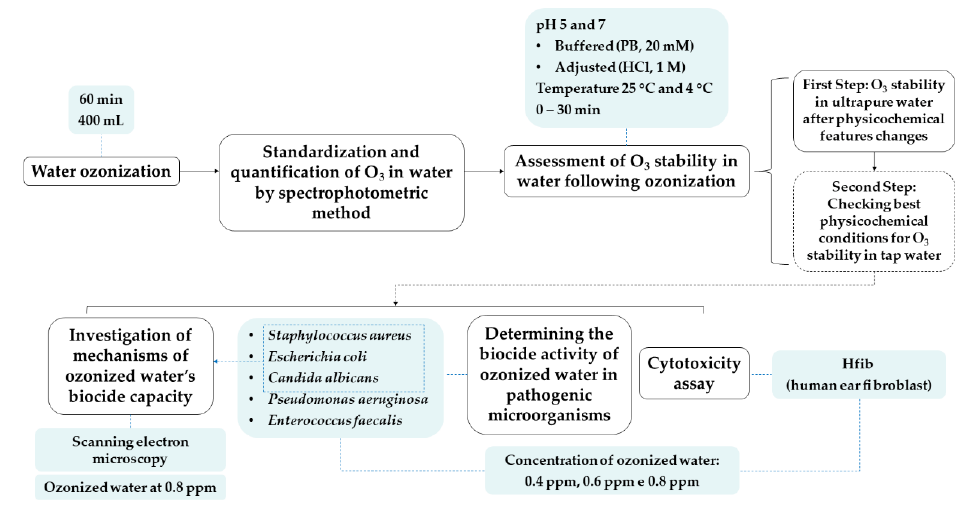
Figure 1. Experimental design. Synthesis of the methodology applied in this study.